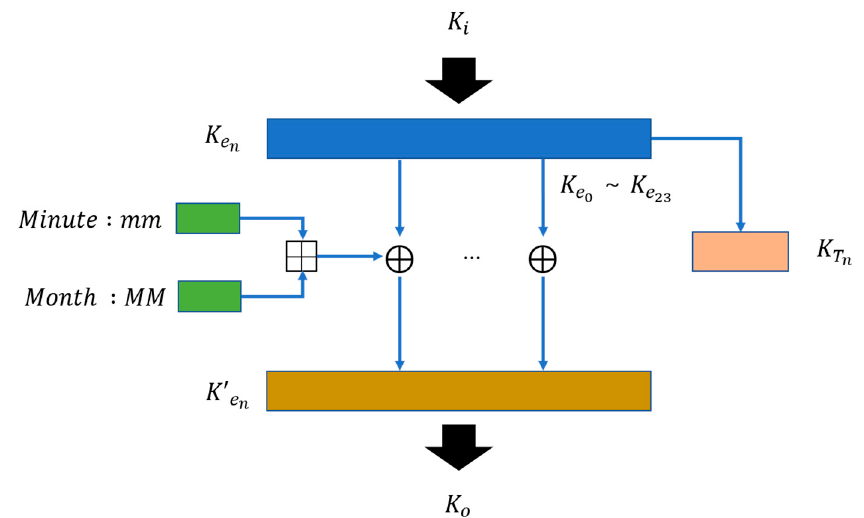
Figure 9. Process through which cipher keys are